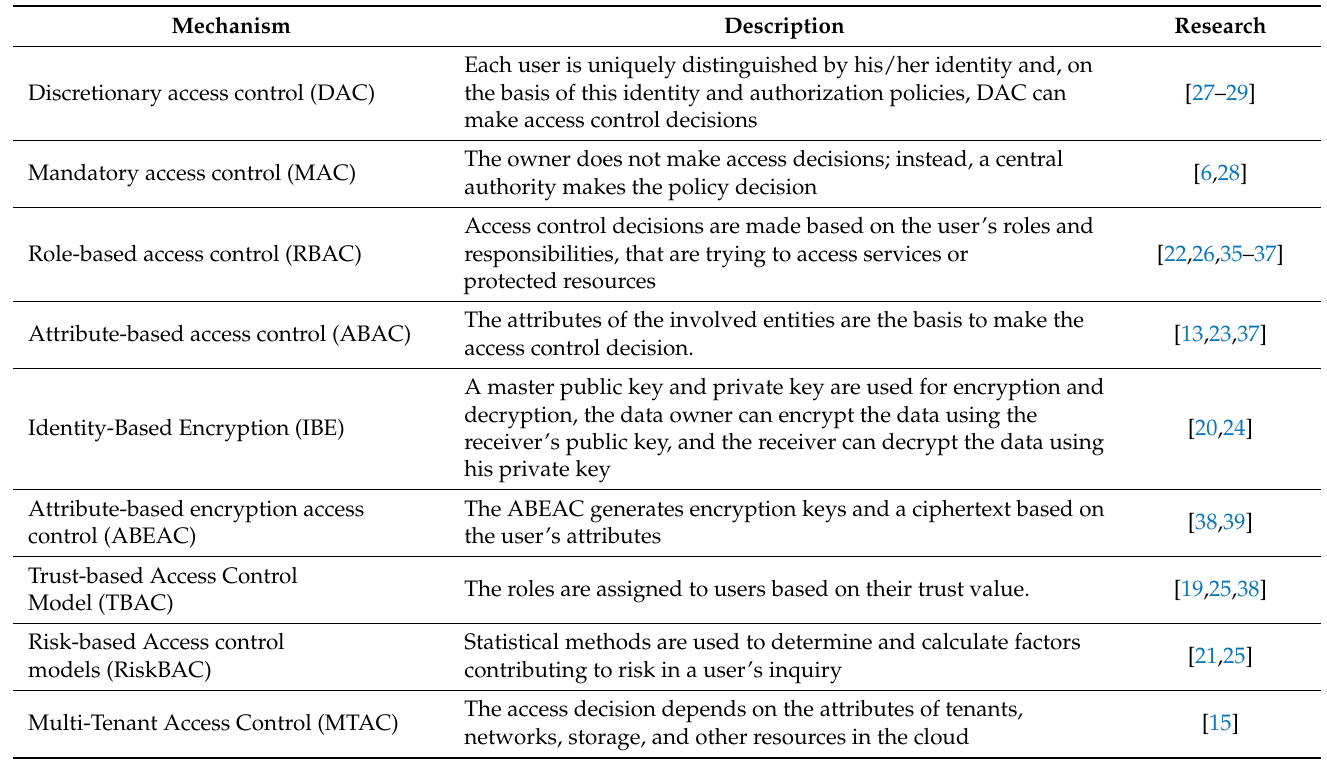
Table 2. Access control mechanisms included in the